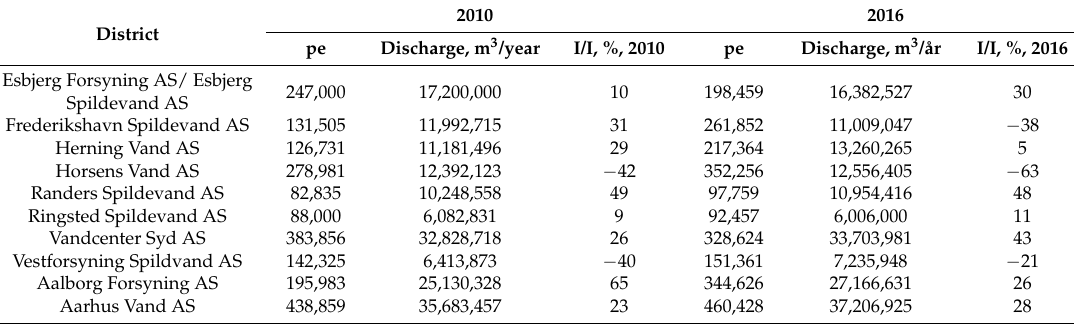
Table 8. Numbers of pe, discharge and percentage of I/I-water for some investigated Danish wastewater districts for 2010 and